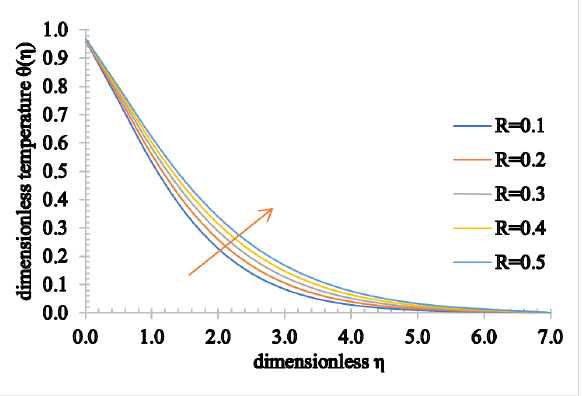
Figure 14: The temperature profile for increasing values of R